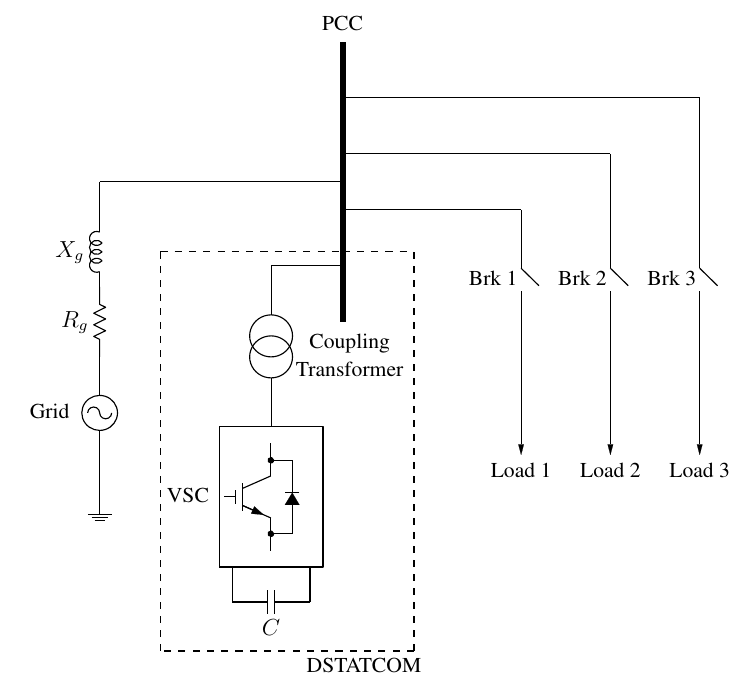
Figure 1. Example of a grid feeding three loads and a DSTATCOM connected to the